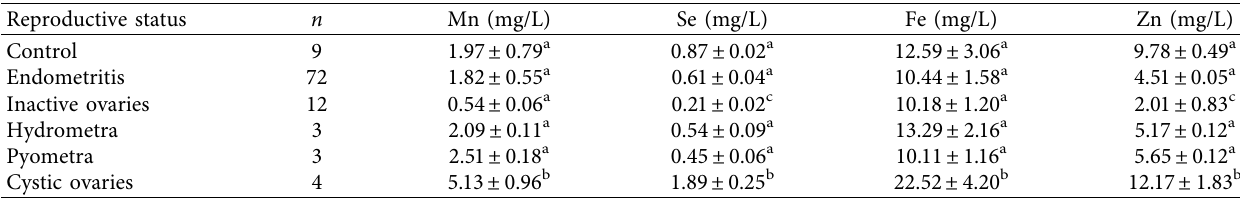
Table 2: Manganese (Mn), selenium (Se), ferrous (Fe), and zinc (Zn) serum levels in goats with various reproductive disorders compared with control.